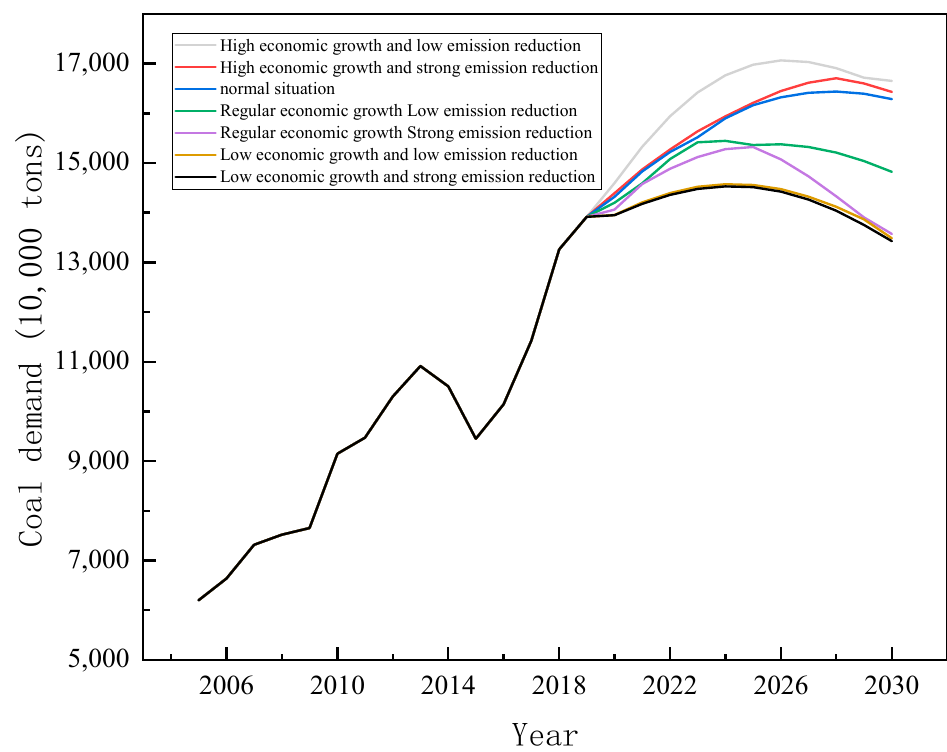
Figure 6. Forecast results of thermal coal demand in Shanxi Province from 2020 to